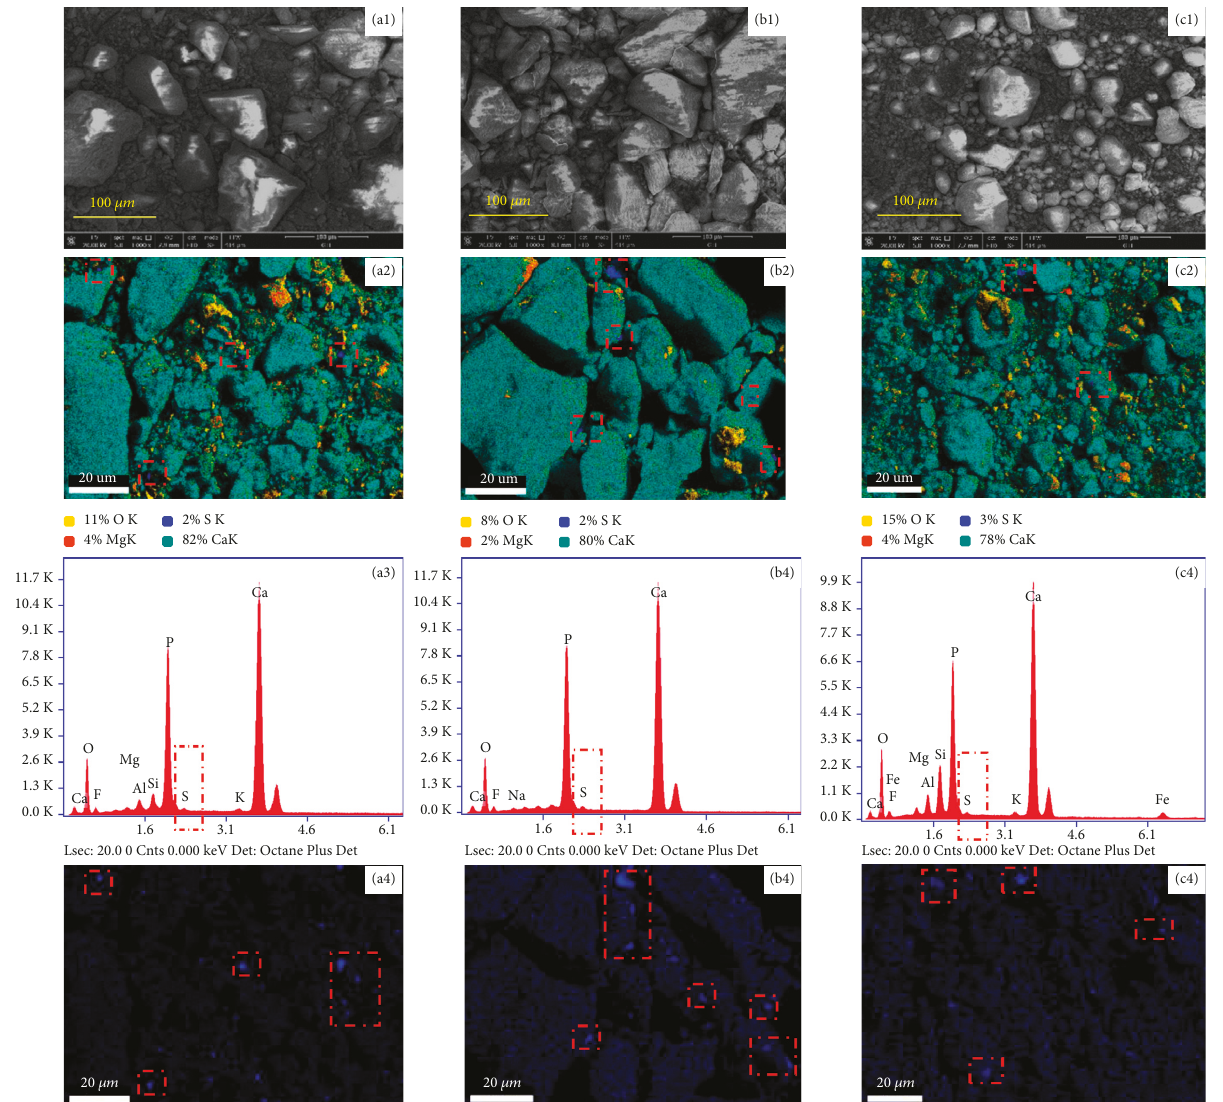
Figure 6: SEM and EDS images of phosphate rocks: (a) KYP series; (b) WAP series; (c) ZJP series; the number 1 represents SEM images, while 2, 3, and 4 represent EDS